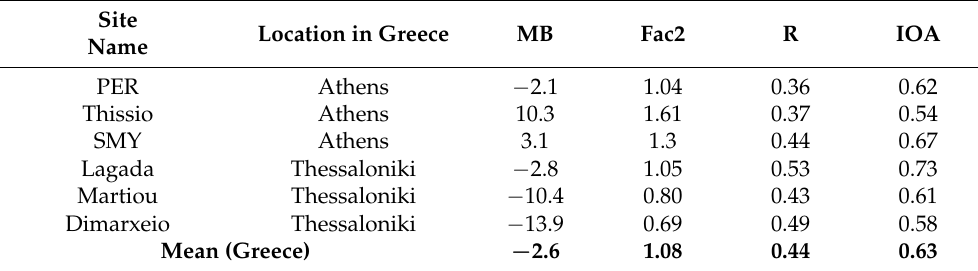
Table 4. Statistical metrics for NO 2 mean daily concentrations ( µ g/m 3 ) for each monitoring site over Thessaloniki, Greece (for d03 domain, 2 × 2 km 2 ) and the rest of Greece (for d02 domain, 6 × 6 km 2 )